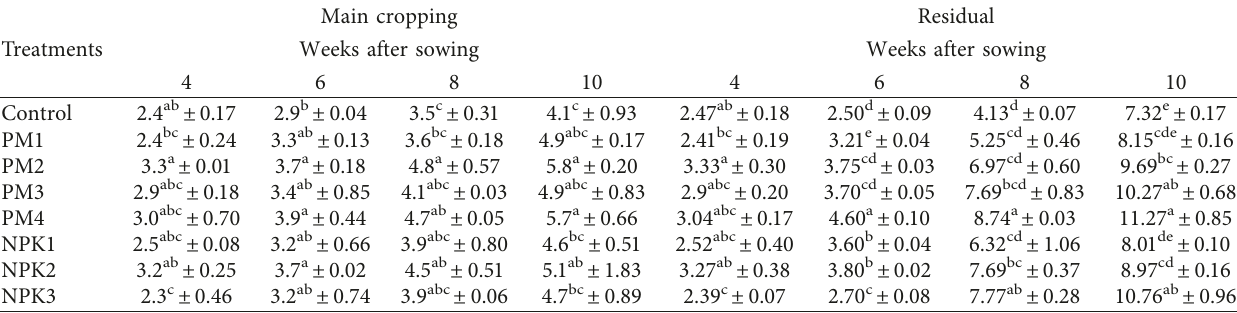
Table 4: Effect of different rates of chicken manure and NPK fertilizers on girth (cm) of sunflower plants. Main cropping Residual Treatments Weeks after sowing